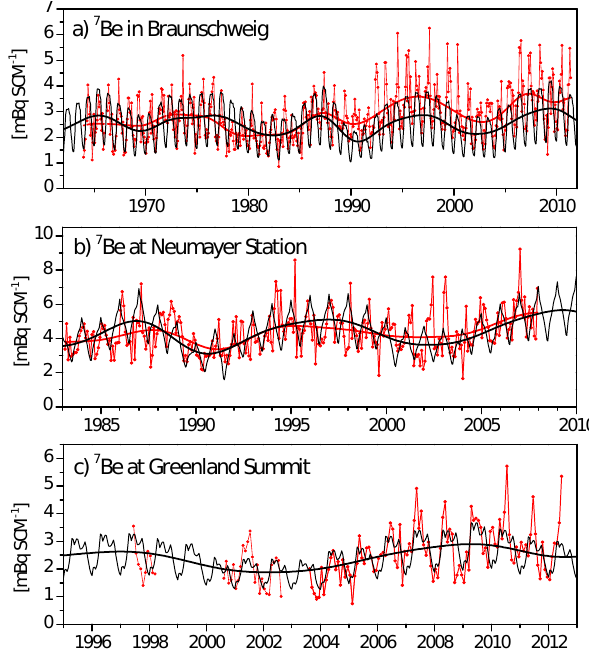
Figure 2. Comparison of measured (red circles) and modeled (black lines) 7 Be air concentration time series (a) in Braunschweig, (b) at coastal Antarctica (Neumayer Station) and (c) at Greenland Sum- mit Station (near GISP2 drilling site). Model results (based on Usoskin and Kovaltsov (2008) production rate calculations) clearly match both features of the measurement time series, seasonal vari- ations and decadal production changes. Note that the Greenland and Antarctic model results are tuned to the overall mean 7 Be air concentration. In the case of the Braunschweig (52 ◦ N) model– measurement comparison, the shown model results are 40–50 ◦